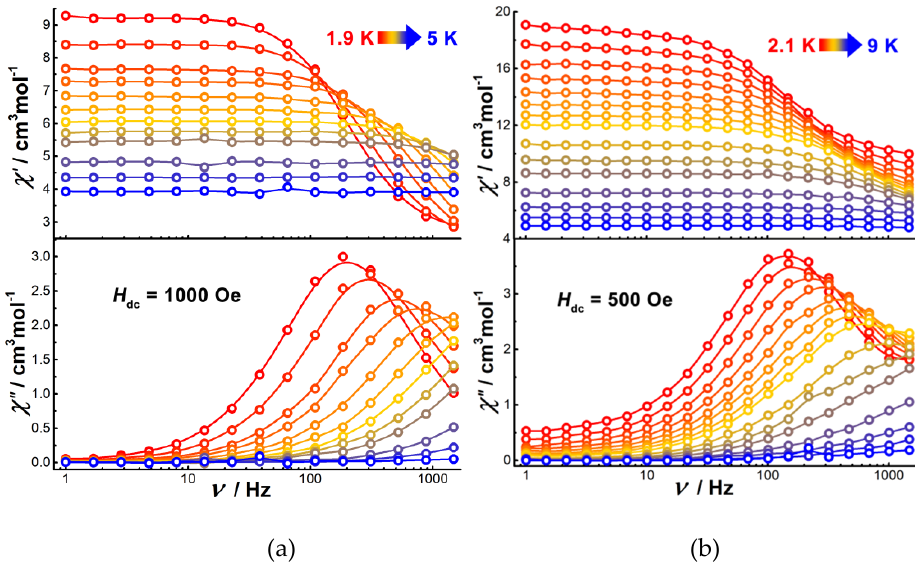
Figure 3. Frequency-dependent ac susceptibility of Dy 2 ( a ) and Dy 4 ( b ) under indicated dc field and temperature. The dots and solid lines are the data from ac measurements.